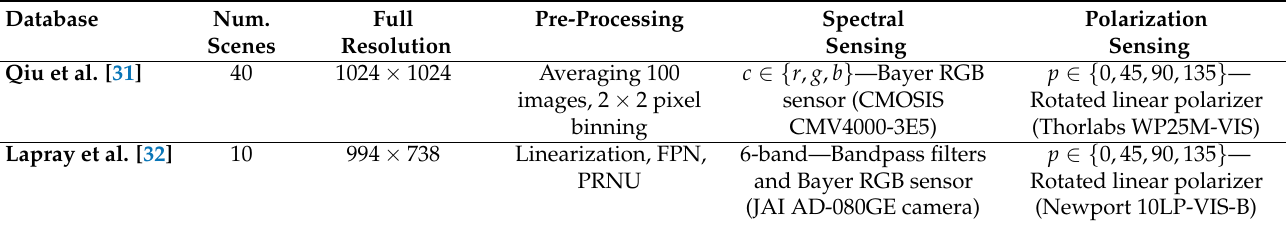
Table 1. Summary of the databases that were used in this